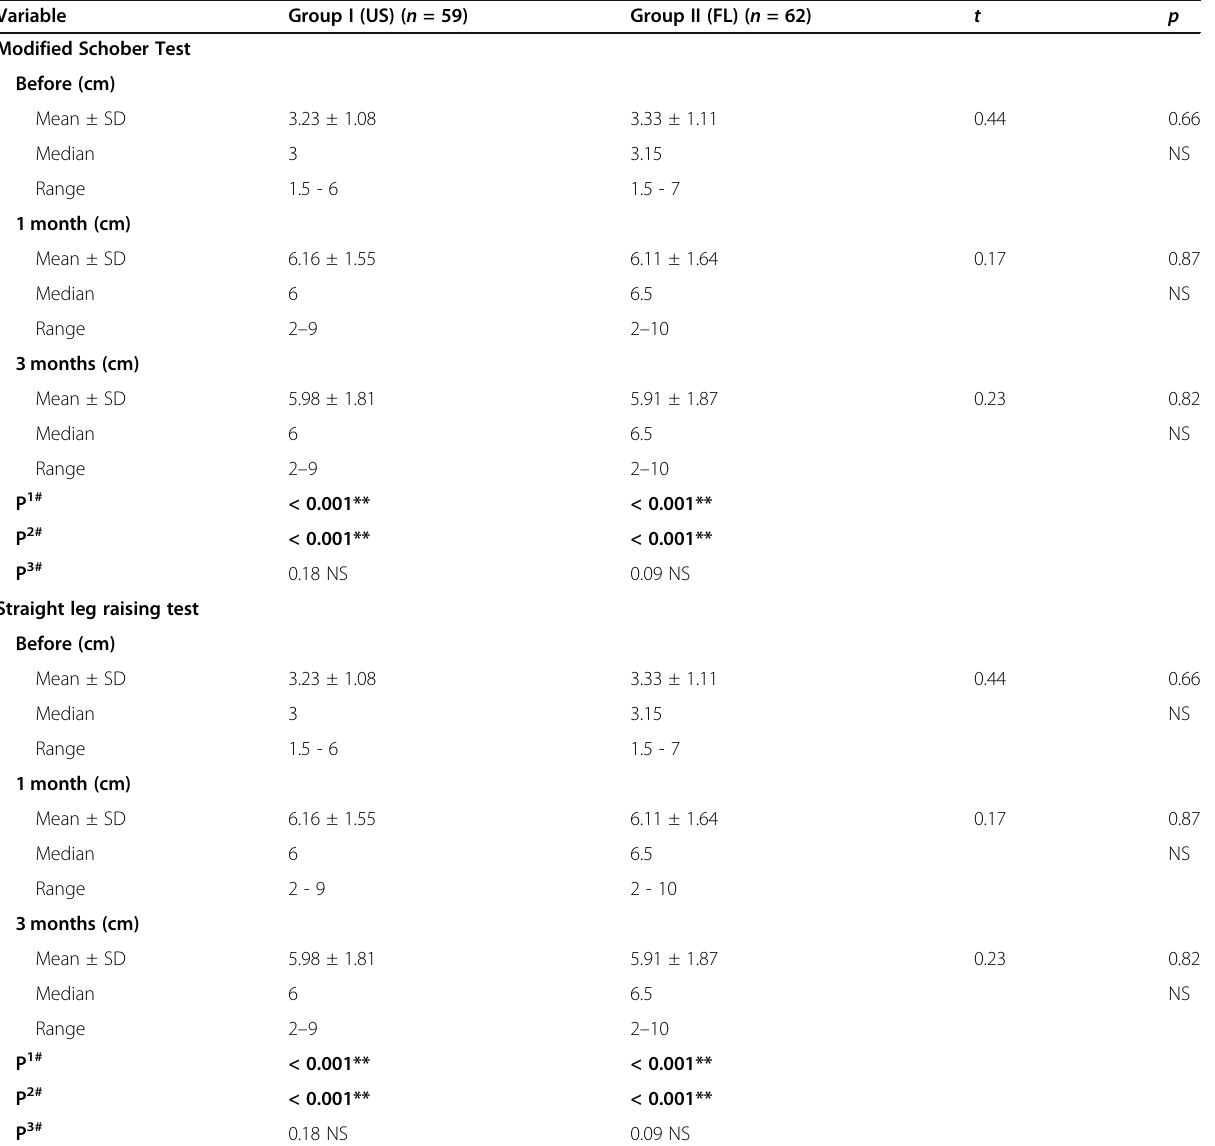
Table 4 Clinical tests of the two studied groups Variable Group I (US) ( n = 59) Modified Schober